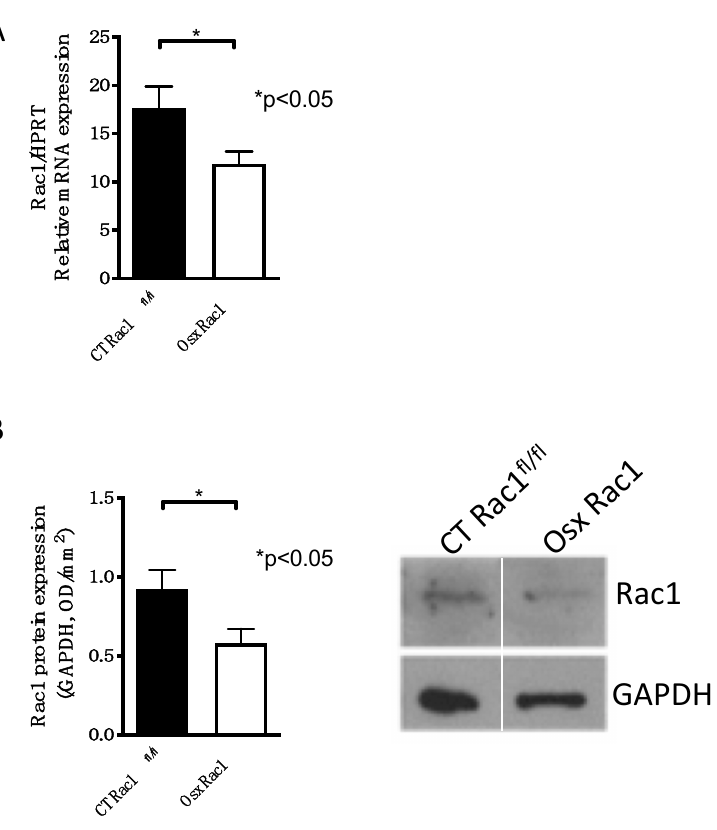
Figure 1. Successful deletion of Rac1 in osteoblasts using osterix to drive Cre recombinase expression. ( A ) Rac1 mRNA expression is diminished in primary newborn calvarial osteoblasts isolated from Osx Rac1 animals compared to cells from littermate controls (CT Rac1 fl / fl ). Rac1 was genetically deleted using osterix to drive Cre recombinase expression in mice homozygous for the floxed Rac1 gene (Osterix-Cre /+ _Rac1 fl / fl : Osx Rac1). The mice were not exposed to doxycycline at any time pre- or postnatally. n = 10 / 10. Rac1 mRNA was adjusted to the housekeeping gene HPRT and the values compared by a t -test. ( B ) Rac1 protein is diminished in primary calvarial newborn osteoblasts from Osx Rac1 mice compared to controls. n = 15 / 13. The protein was adjusted to the housekeeping protein GAPDH. The values were then compared between both groups using a t- test.